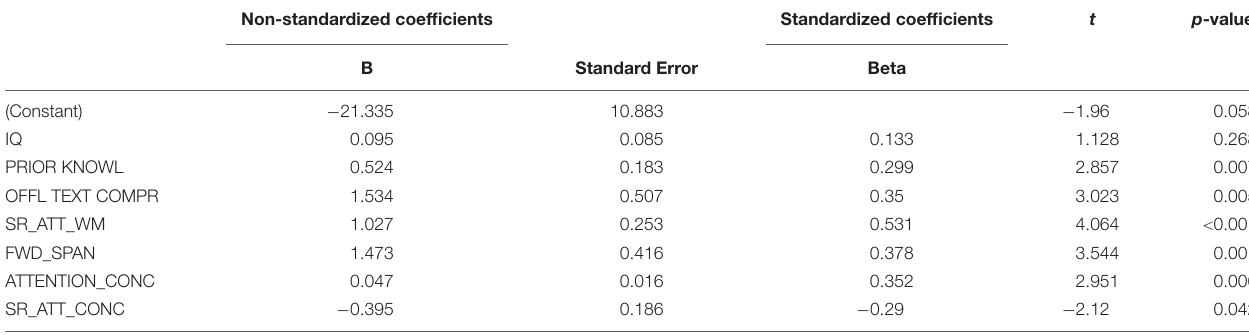
TABLE 2 | Coefficients of the regression equation for Version 1 total score (24 items).